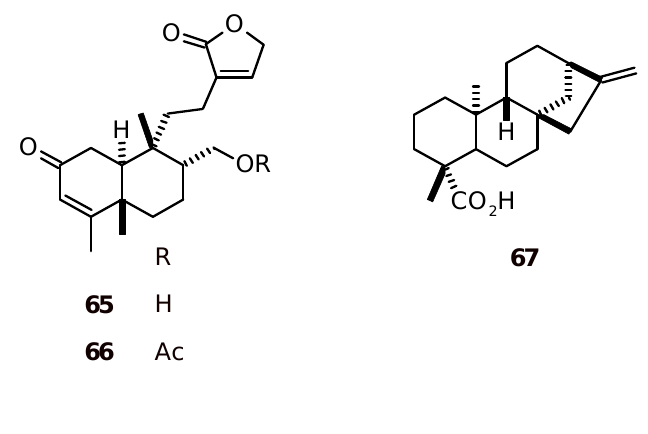
Figure 6. Structures of clerodane and kaurane diterpenes 65-67 .